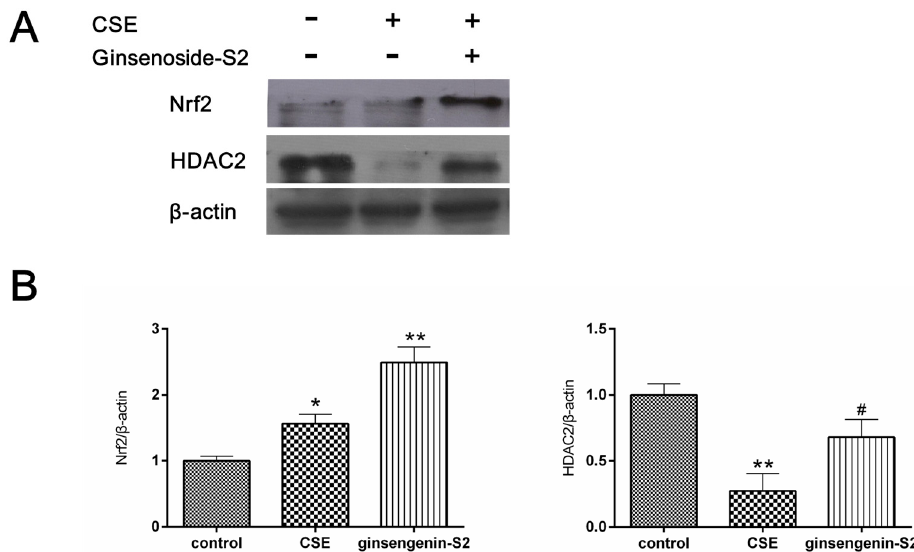
Figure 7. ( A ) Effect of ginsengenin-S2 (100 µ M) on the protein expression of nuclear-related factor 2